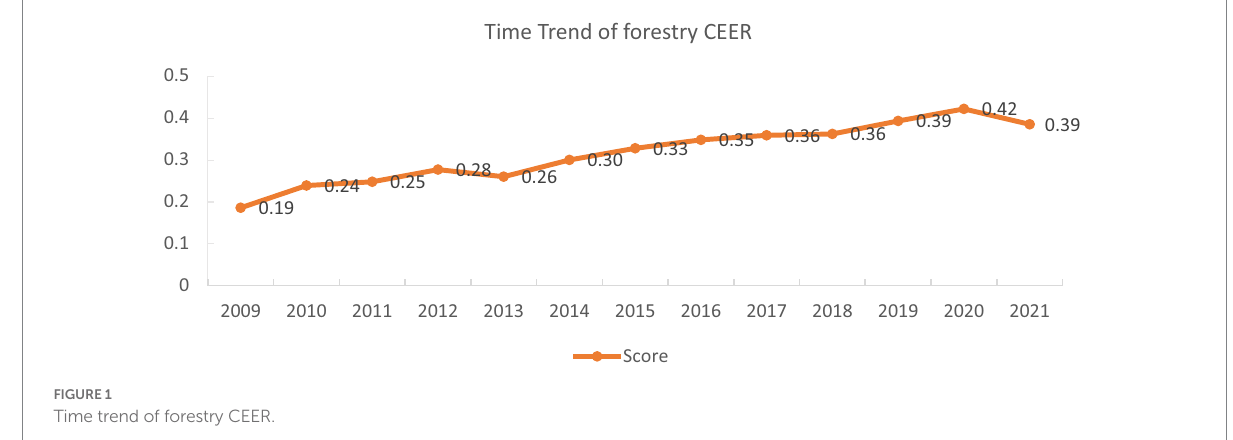
FIGURE 1 Time trend of forestry CEER.